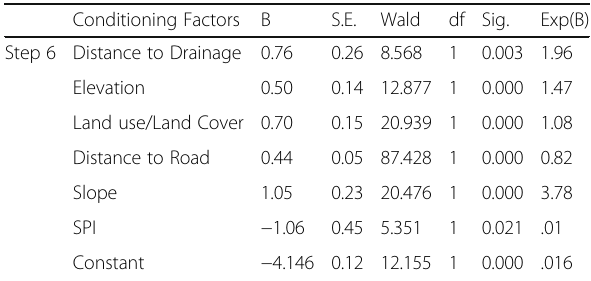
Table 4 Results of Logistic Regression